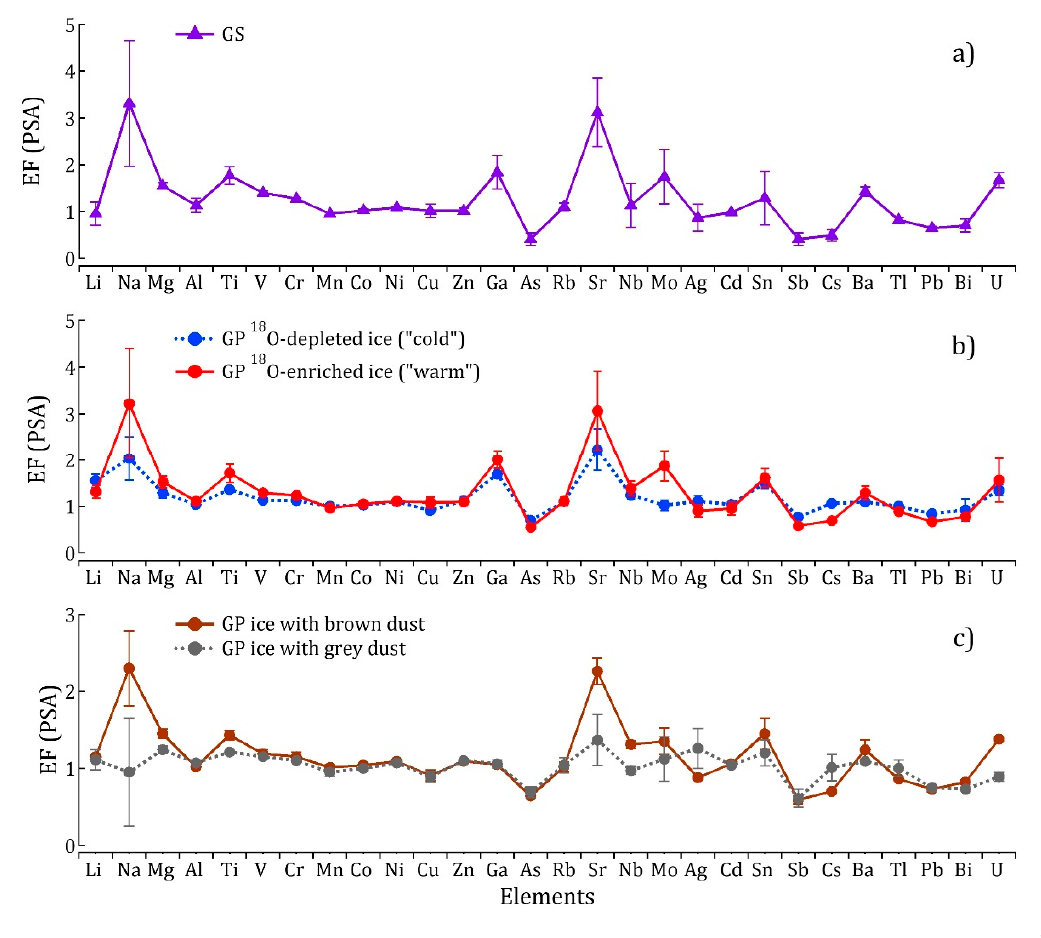
Figure 8. TE average (± st dev) enrichment factor (EF) in ice samples from ( a ) GS, ( b ) 18 O-depleted (cold) and 18 O-enriched (warm) GP sections, ( c ) GP ice sections containing “brown” or “grey” dust. EF is calculated using Fe and the local PSAs [55] as the crustal references. Here, Fe is the preferred crustal element of reference to illustrate the Ti enrichment variability among the various types of ice